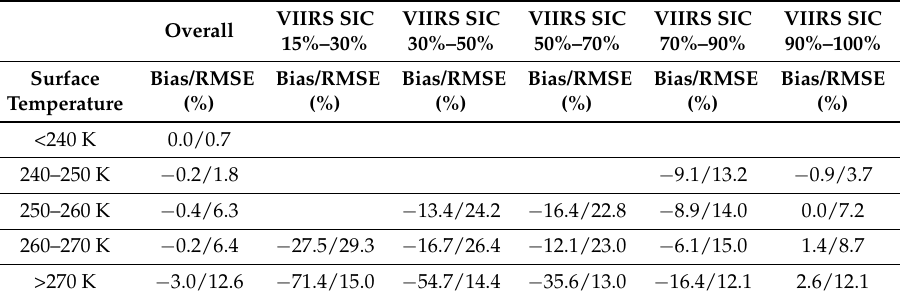
Table 7. VIIRS minus Landsat ice concentrations bias and RMSE with bias removed (precision) for cases where the nighttime ice concentration algorithm was applied to daytime data, over different concentration ranges/bins for different surface temperature ranges with match up pairs more than